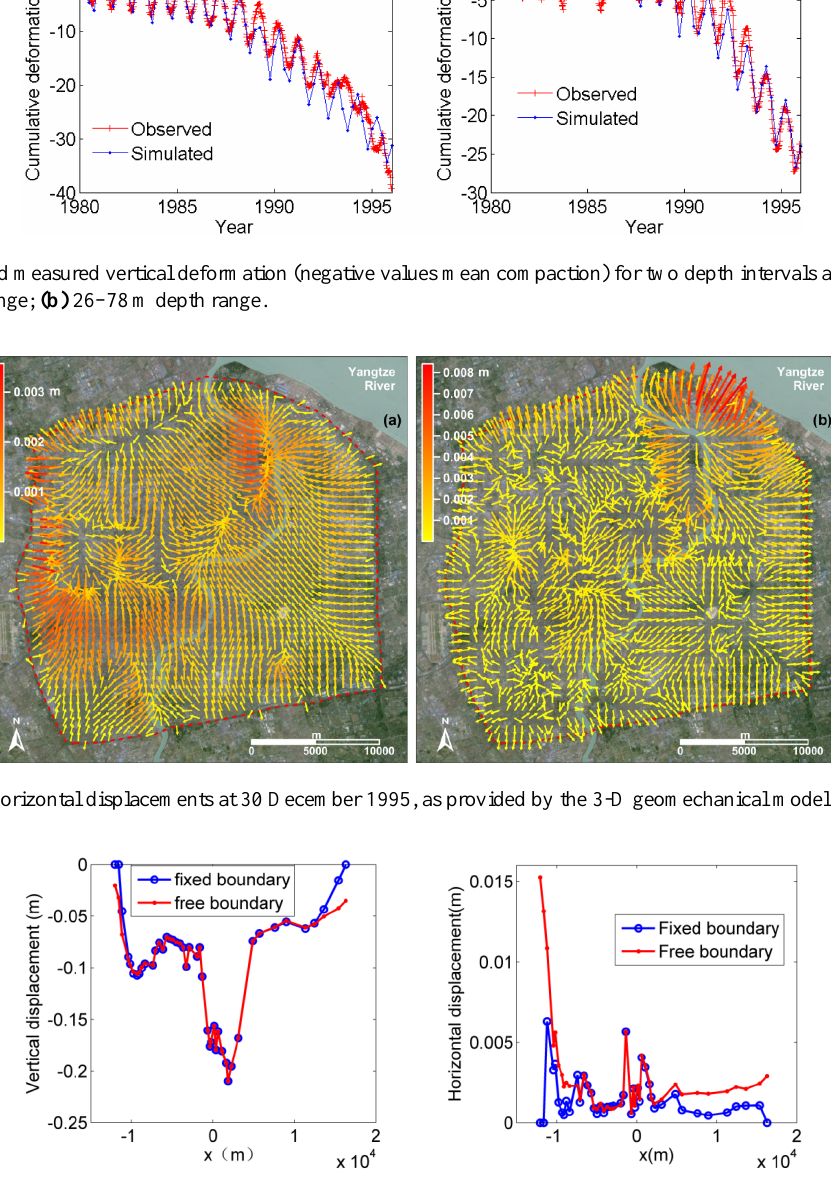
Figure 8. Comparison between the simulated vertical (a) and horizontal (b) displacements provided by the geomechanical model with different boundary conditions along a west-east profile crossing the downtown